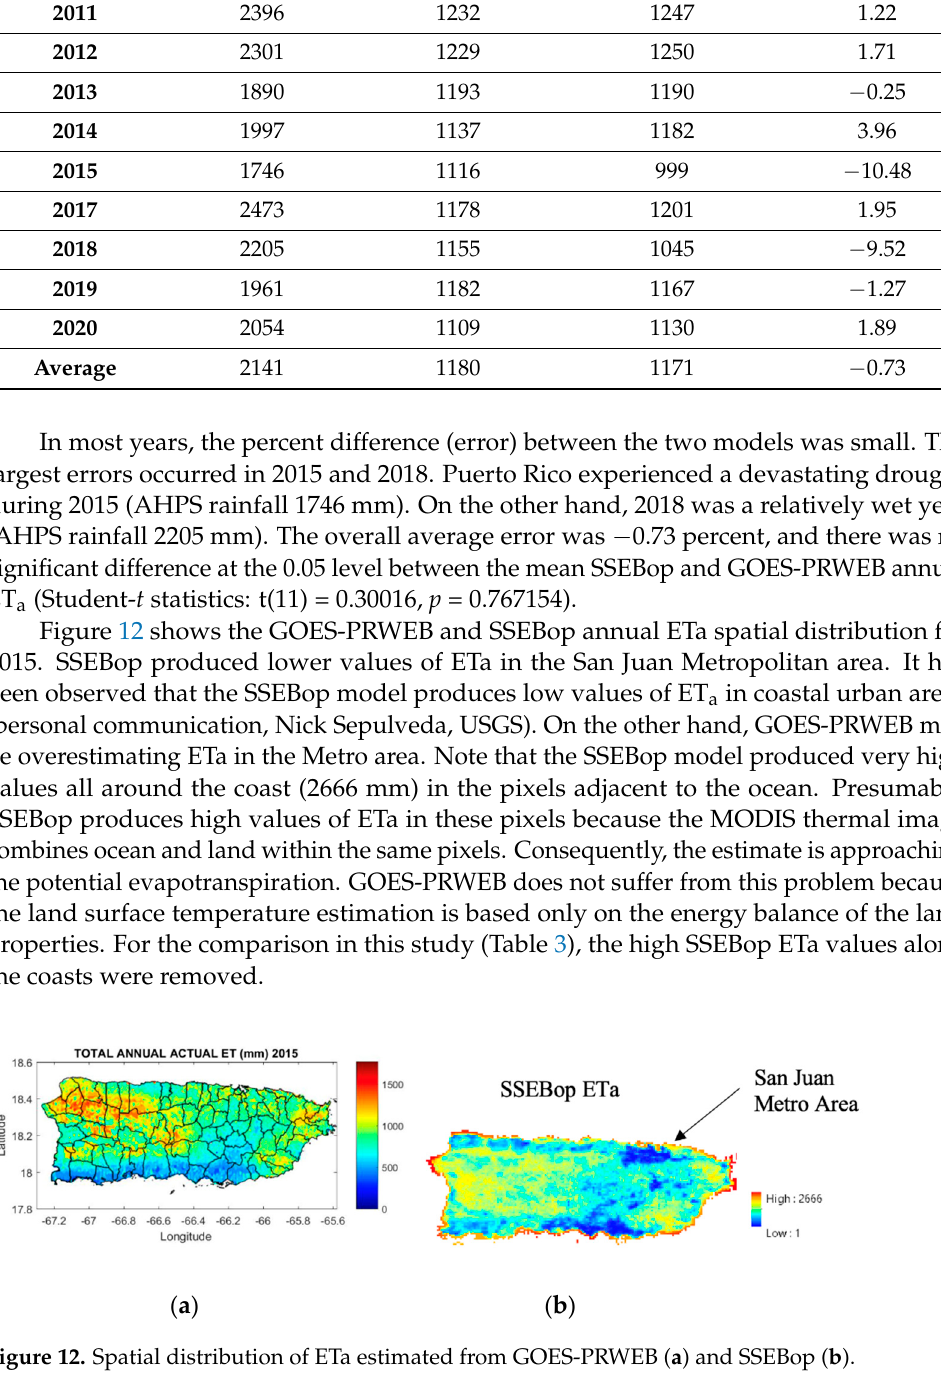
Table 3. Comparison of SSEBop and GOES-PRWEB annual ETa for 2009–2020.